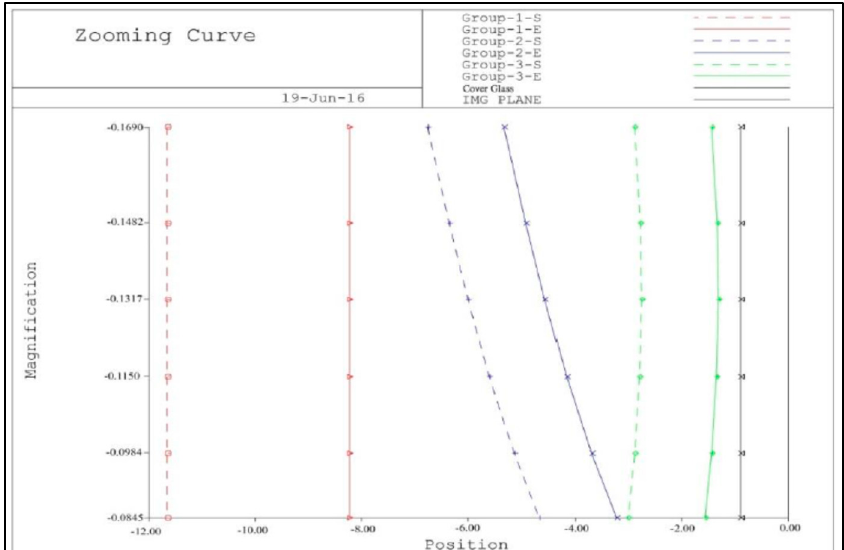
of 0.689 mm, the tangential MTF is 0.448 for a spatial frequency of 121 lp/mm, as shown in Figure 4f. Figure 2. Lens diagrams of the 2× zoom lens at different magnifications.